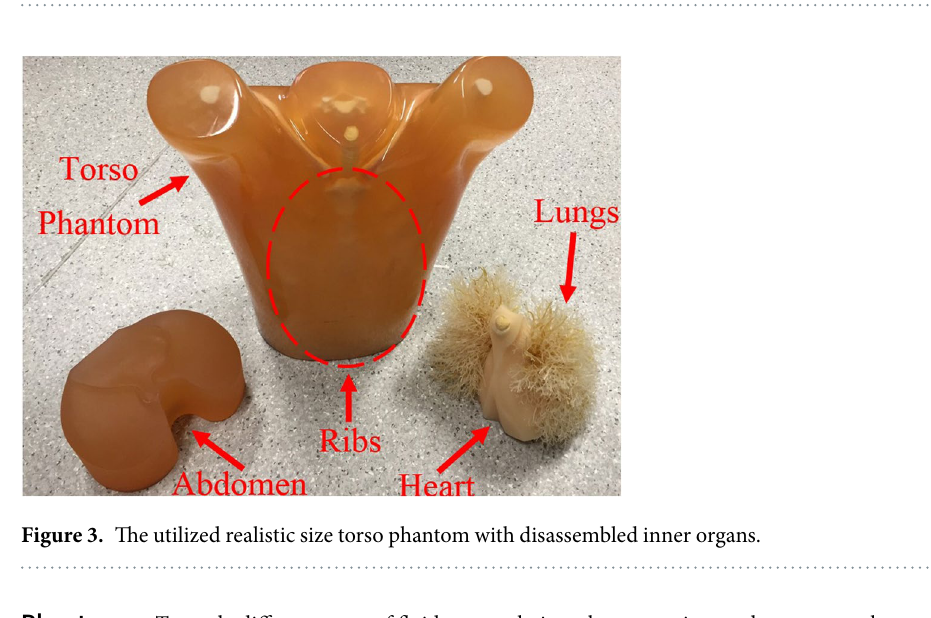
Figure 2. Specific absorption rate distribution in the torso when the antenna at center radiates.